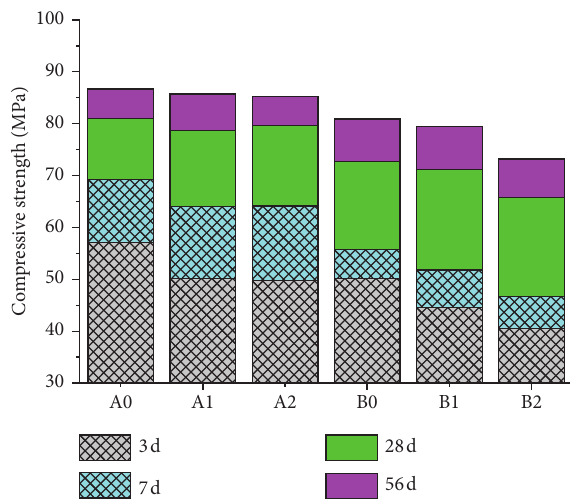
Figure 7: Relationship between compressive strength and age of concrete. (A) Concrete without FA; (B) concrete with FA. Figure 7. This meant that the difference between equation (16) proposed by this study and equation (1) presented by concrete without FA.